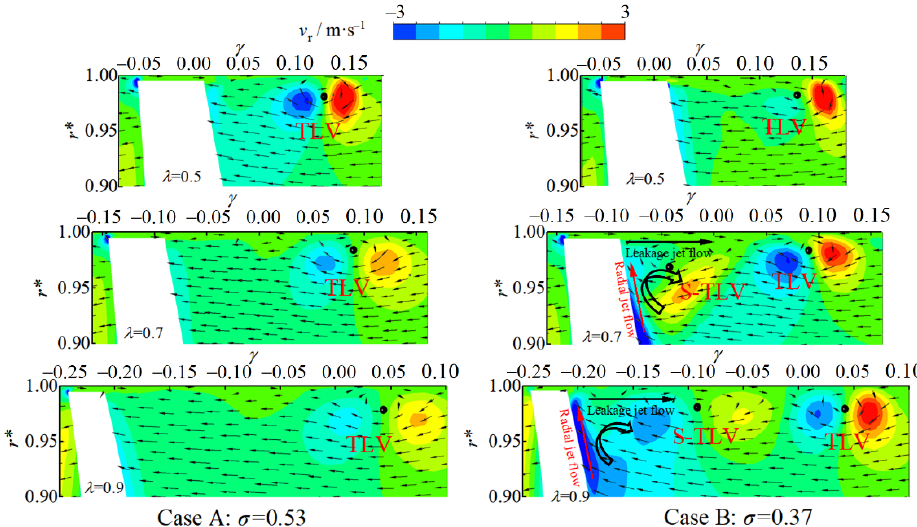
Figure 15. Distributions of radial velocity on three planes.